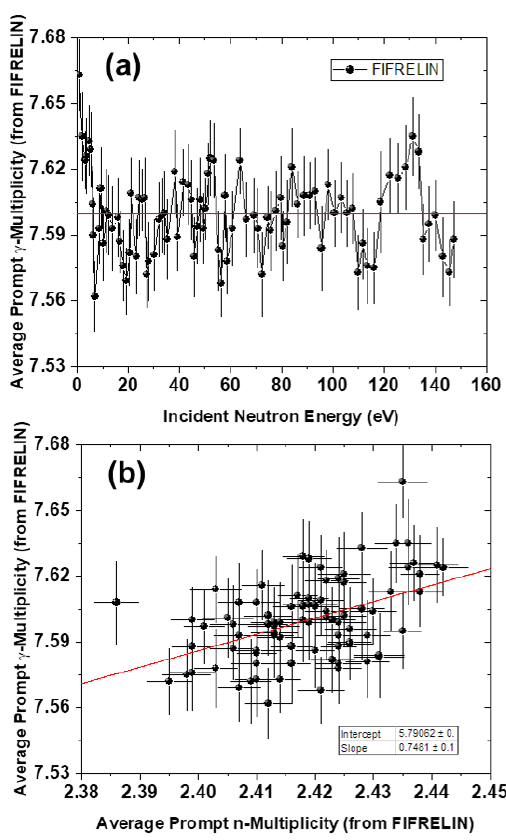
Figure 6. (a): Average prompt gamma multiplicity calculated with FIFRELIN for the 88 resonances. (b) Correlation between the average prompt gamma multiplicity and the prompt neutron multiplicity for the same 88 resonances.